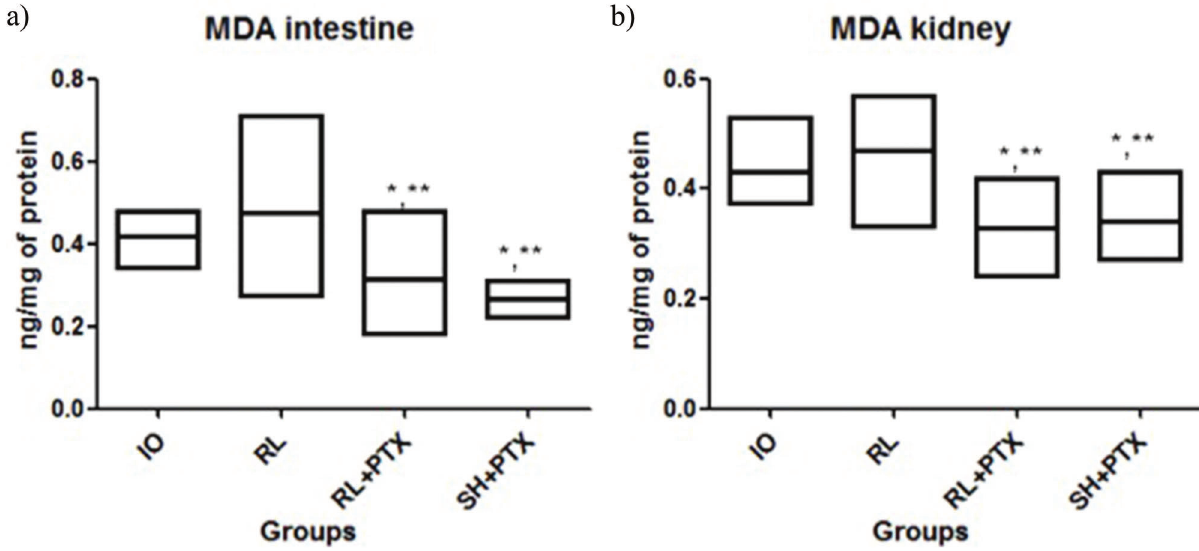
Figure 1 - MDA concentrations (nmol/mg of protein) in the intestine (a) and kidney (b). Wistar rats were assigned to four groups: no resuscitation (IO-intestinal obstruction and ischemia), Ringer ’ s lactate (RL), Ringer ’ s lactate + pentoxifylline (RL + PTX), and hypertonic saline + pentoxifylline (HS + PTX). Data are expressed as the medians (interquartile range). ( p o 0.05) * versus IO; ** versus RL; # versus RL +